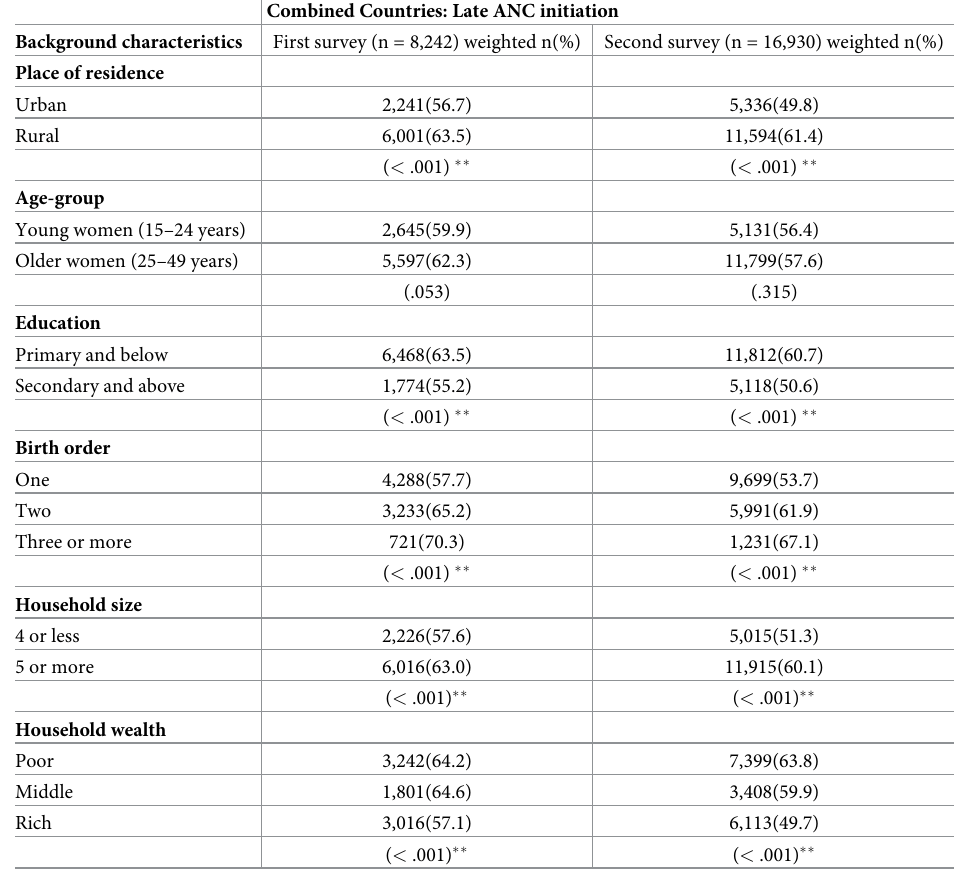
Table 1. Late ANC initiation by background characteristics in the combined